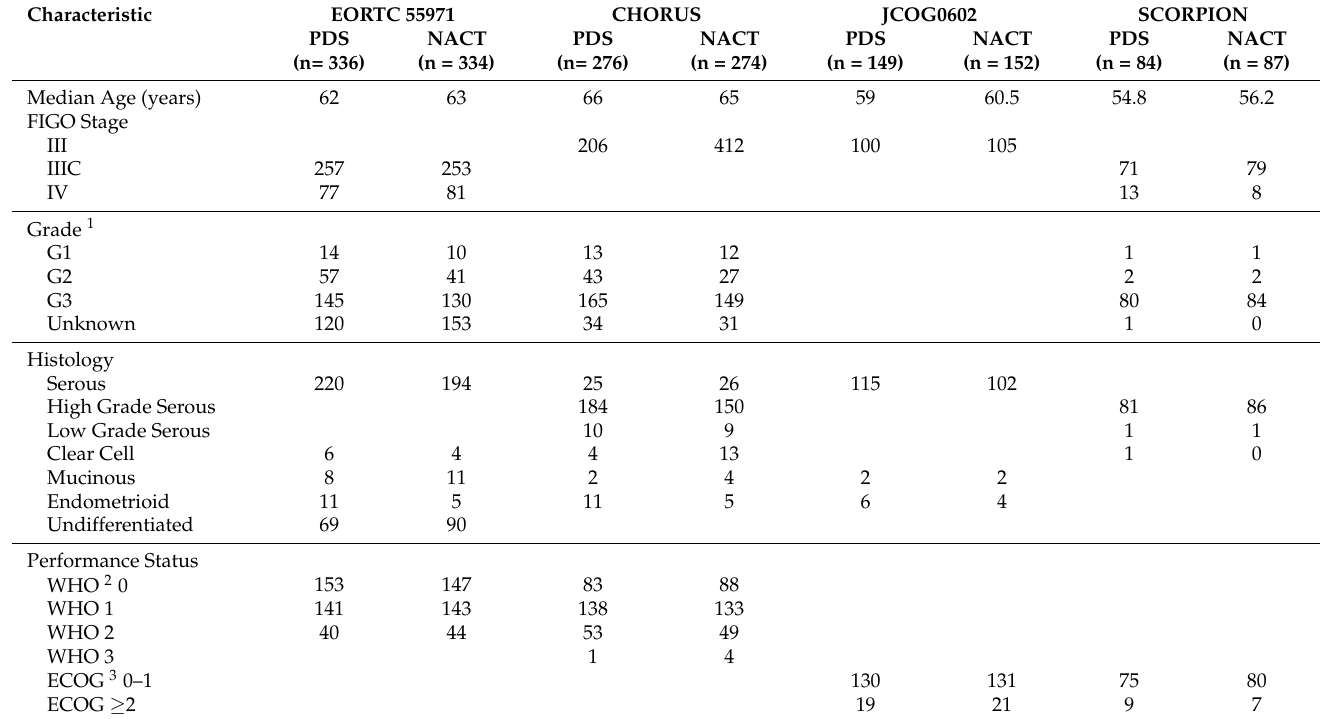
Table 2. Summary of baseline characteristics of patients included in randomized trials comparing NACT to PDS.